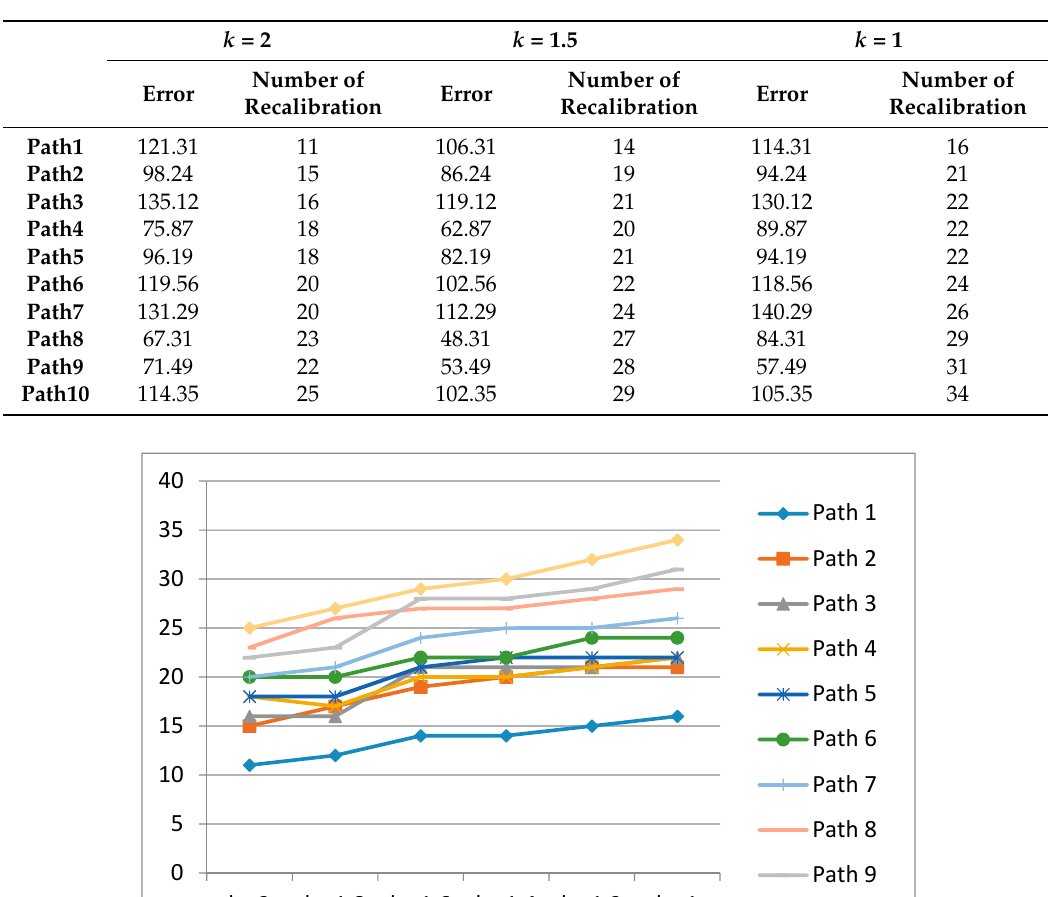
Table 4. Error distribution according to recalibrations for large area (unit: cm).